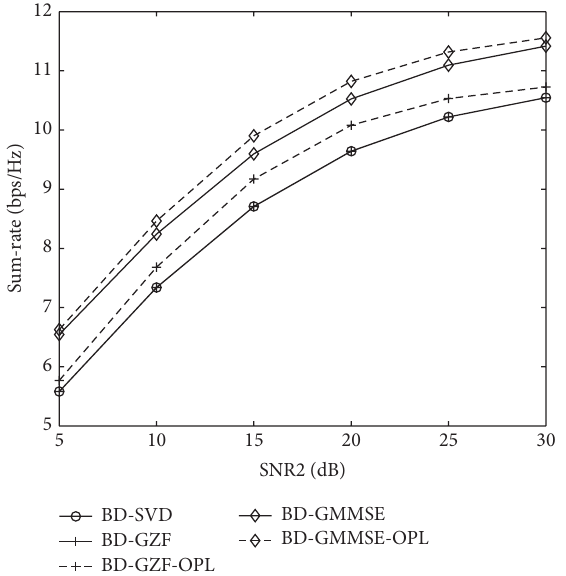
Figure 4: Sum-rate as a function of SNR2 with SNR1 fixed at 10